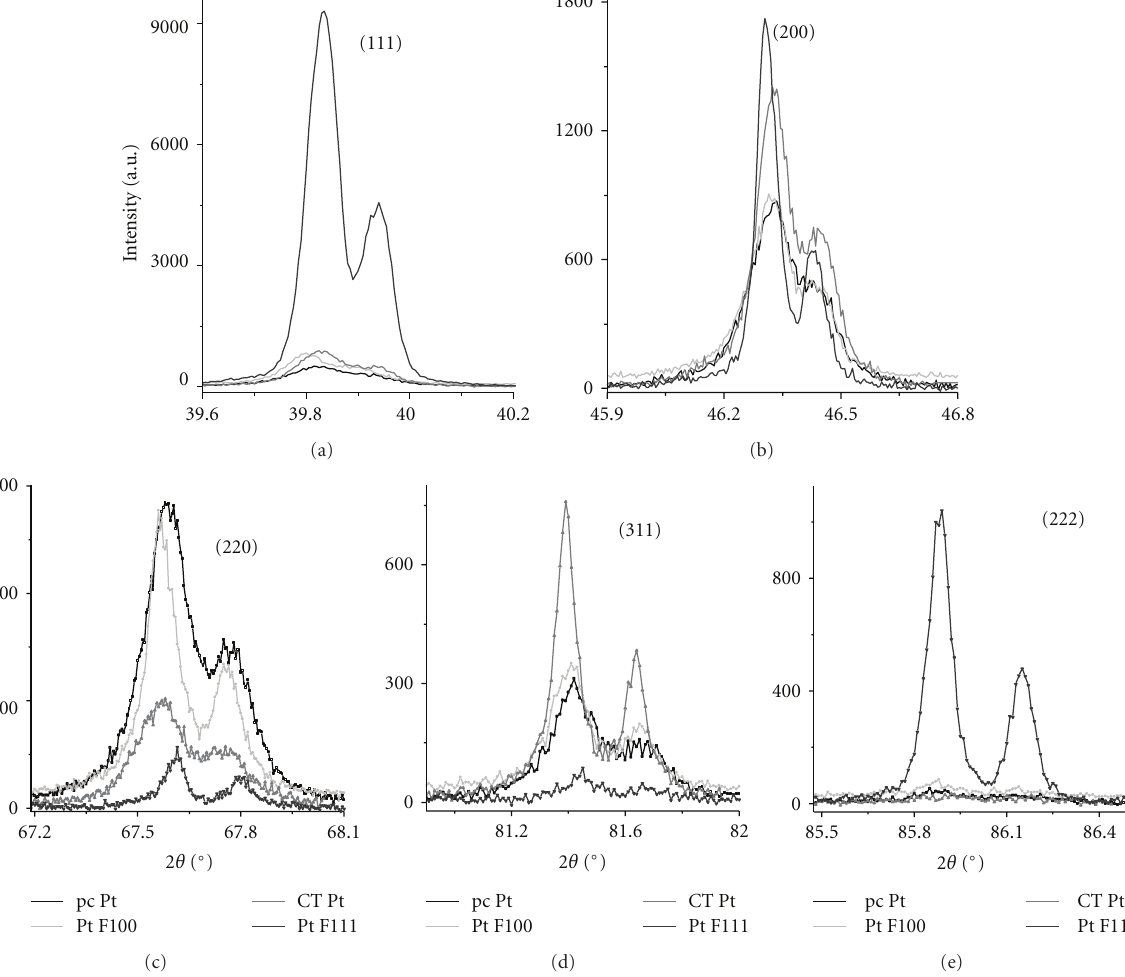
Figure 2: Ex situ X-ray powder di ff raction pattern peaks (111), (200), (220), (311), and (222) for pc Pt (black lines), Pt F100 (light grey lines), CT Pt (grey lines), and Pt F111 (dark grey lines).